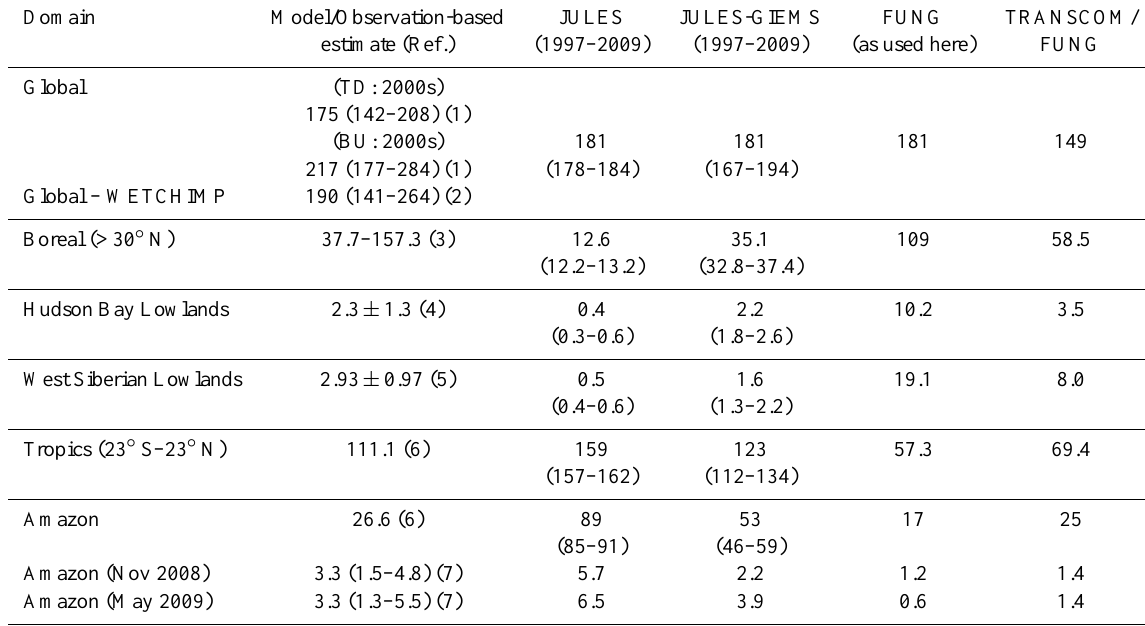
Table 2. Comparison of global and regional estimates of methane emissions from wetlands.